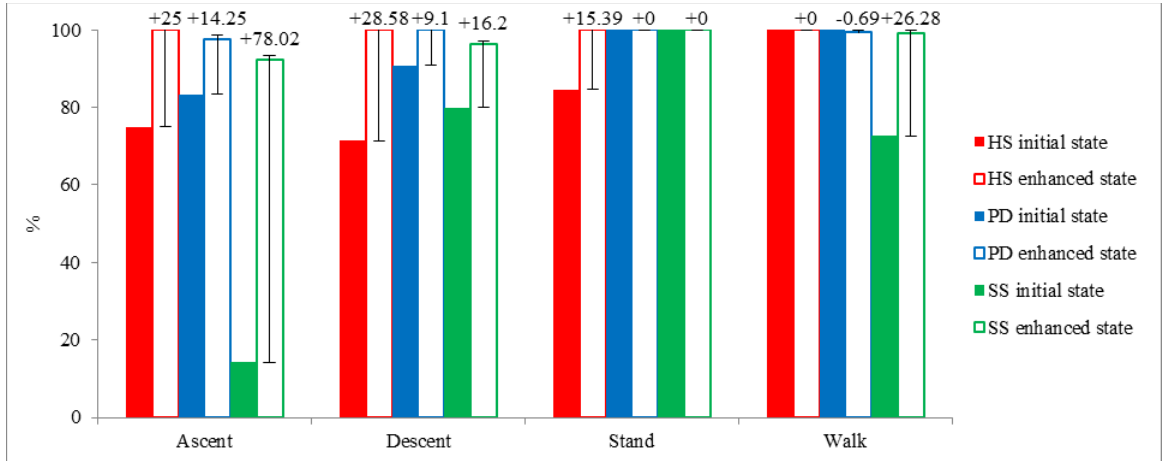
Figure 4. Recognition accuracy comparison of each activity in the initial result of the local